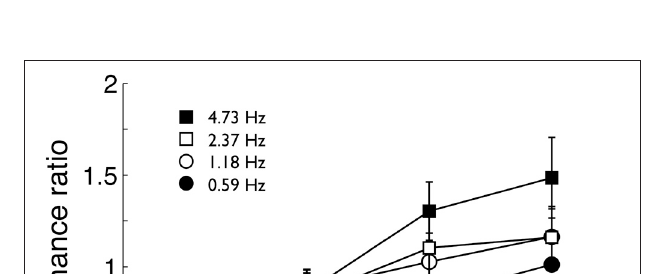
FIGURE 1 | All stimuli were made from a random dynamic noise sequence that was filtered in both the spatial and temporal dimensions into narrowly defined pass-bands. The upper part of the figure illustrates the spatial filtering. All stimuli in these experiments were isotropically filtered into a fixed spatial pass-band ranging from 0.8 to 1.6cyc/deg. The lower row illustrates how the noise sequences were filtered in the temporal dimension so that the modulation rate over time could be carefully controlled. Six narrow temporal pass-bands were used in